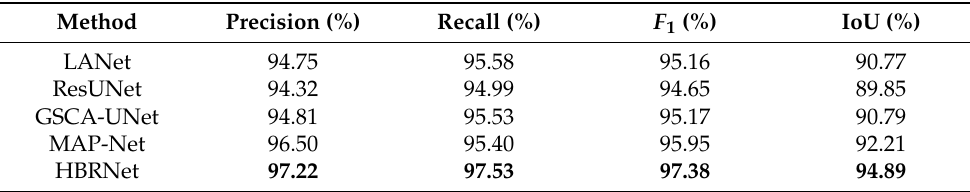
Table 3. Quantitative comparison (%) vs. several other methods on the AG dataset. The best performance are marked as